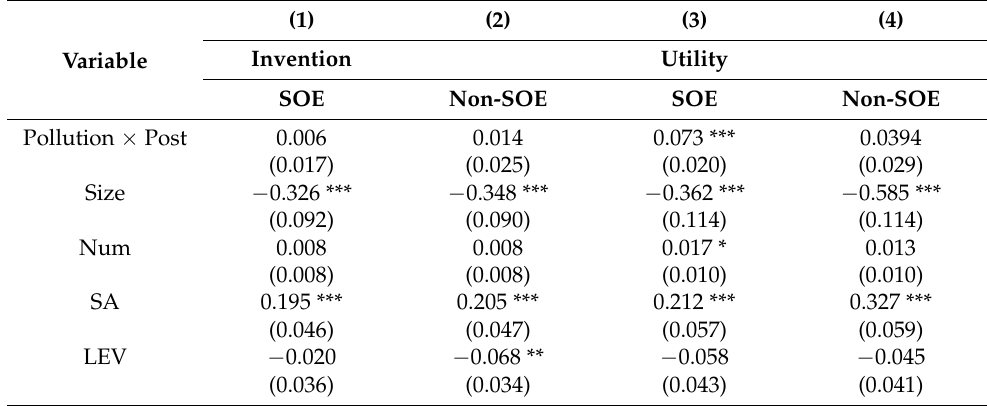
Table 10. Analysis of the heterogeneity of the